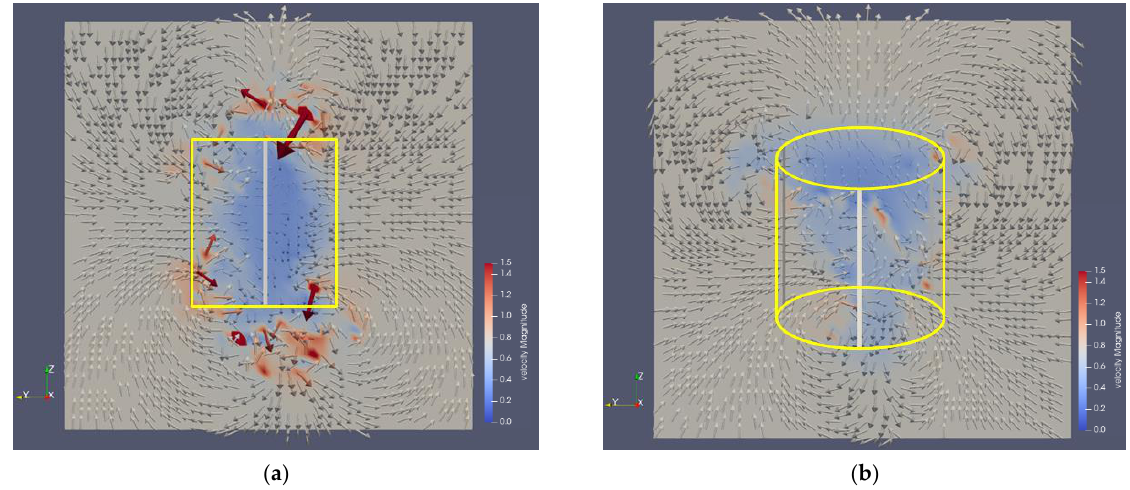
Figure 9. Wind velocity vector in the YZ-plane ( a ) upright; ( b ) 20-degree tilt.